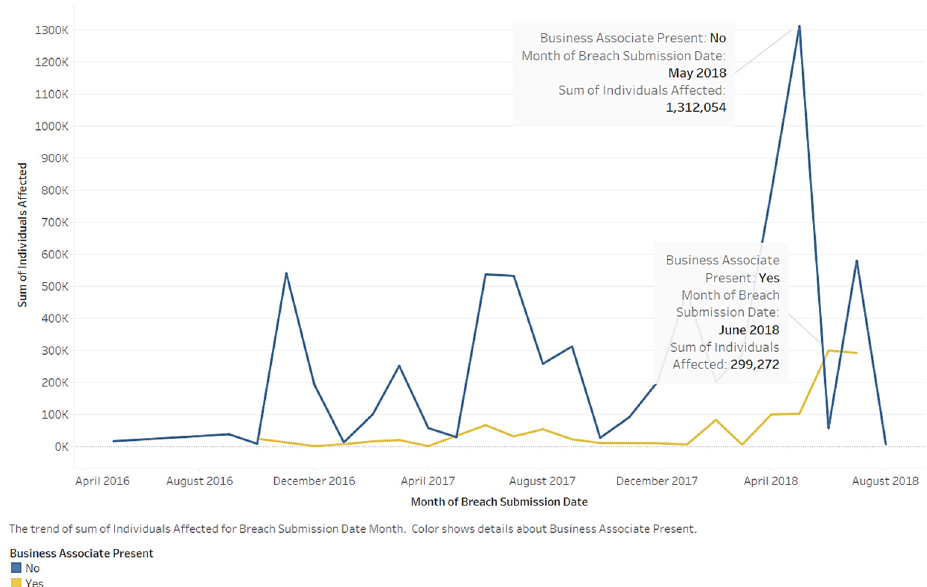
Figure 17. Trend of individuals affected by breach and business associate presence.